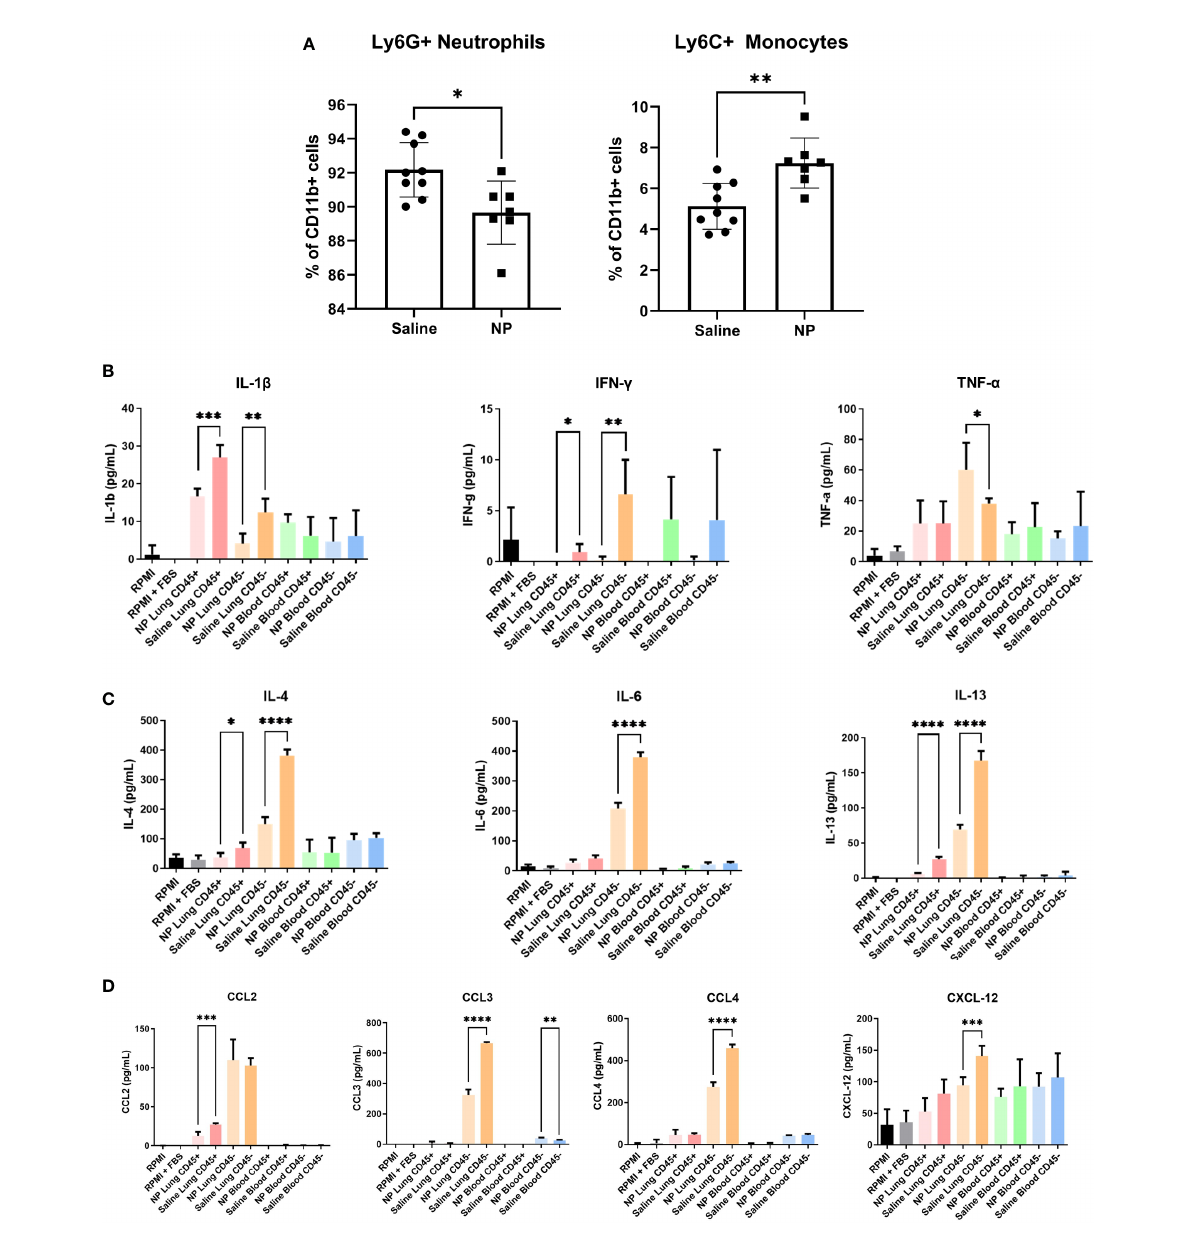
FIGURE 4 In vivo administration of NPs modulates immune cell composition and secretome. (A) Flow cytometry quanti fi cation of Ly6G+ neutrophils and Ly6C+ monocytes in peripheral blood of 4T1-bearing mice that received NPs (n=7) or saline (n=9). Ratios are calculated as % of CD11b+ myeloid cells. CD45+/- cell fractions were magnetically sorted form peripheral blood and lungs, and cultured for 16h in vitro . Secretome was analyzed with ELISA (n=5 mice per group) for cytokines associated with (B) Th1 and (C) Th2 responses, and (D) chemokines. Two-tailed unpaired t-tests assuming unequal variance were performed for single comparisons between two conditions, * p ≤ 0.05, ** p ≤ 0.01, *** p ≤ 0.001, **** p ≤